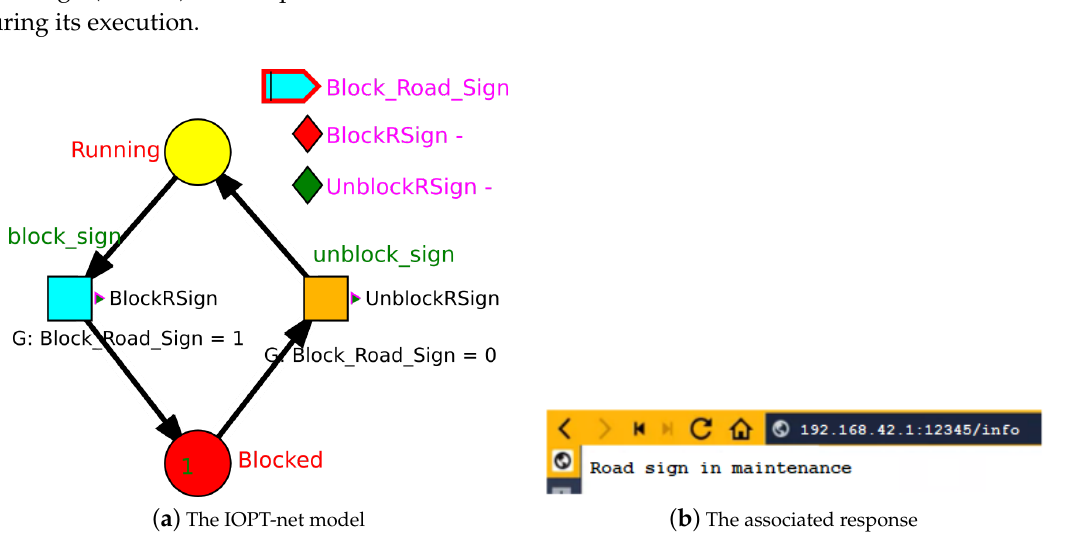
Figure 14. The maintenance mode controller of the DBC module.